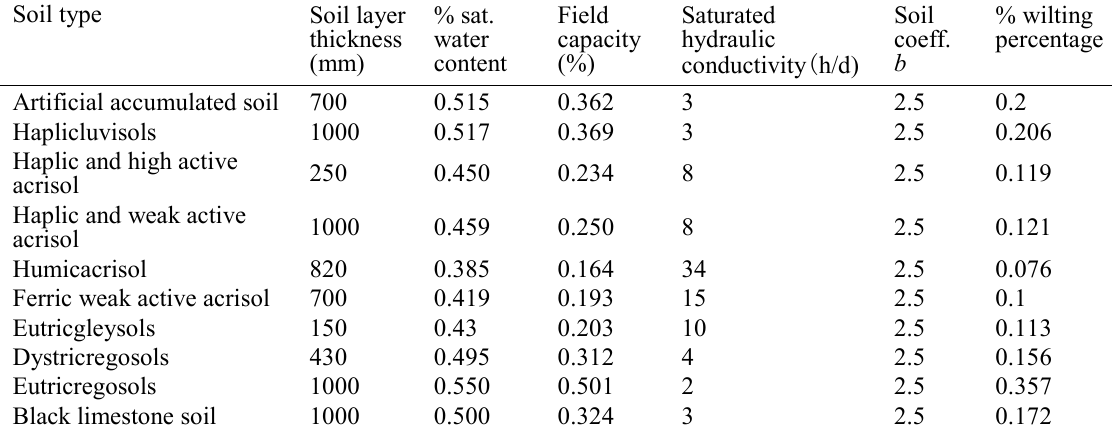
Table 2 Preliminary values of soil related